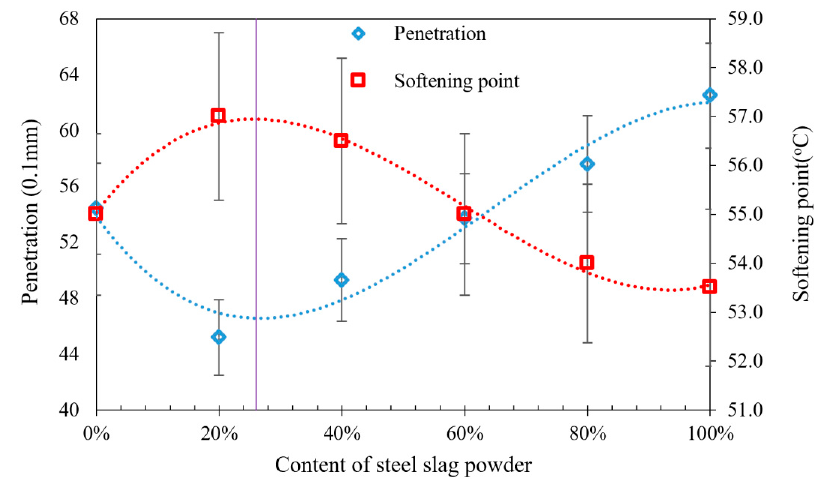
Figure 4. Results of penetration and softening point of P-AM.